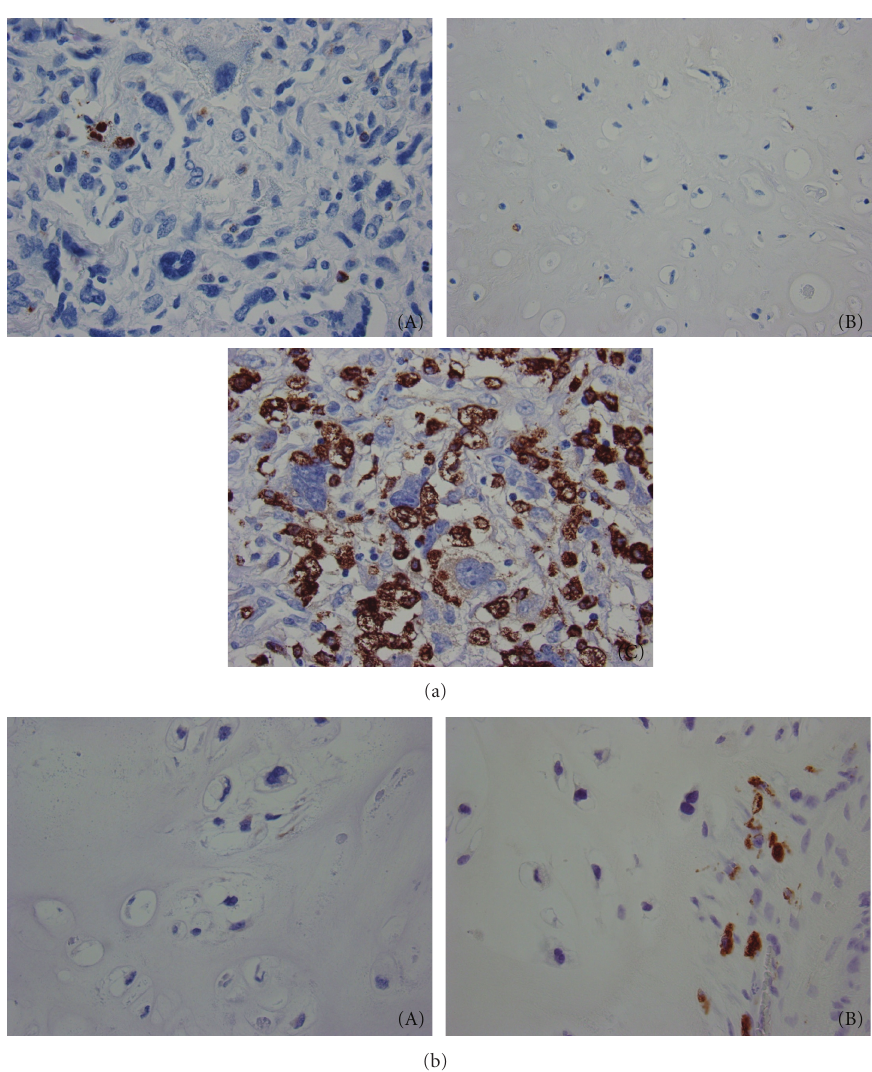
Figure 4: (a) CD68 staining demonstrates rare intratumoral macrophages in both the high-grade (A) and low-grade (B) components of the primary tumor from the patient A, whereas numerous intratumoral macrophages were present throughout the lung metastases (C) (40x, CD68). (b) (A) Stains for CD68 reveal very few intratumoral macrophages within a primary low-grade chondrosarcoma from the patient B (40x, CD68). (B) CD68 stains of the local recurrence highlight a few macrophages in the adjacent fibroconnective tissue but no intratumoral macrophages (40x,